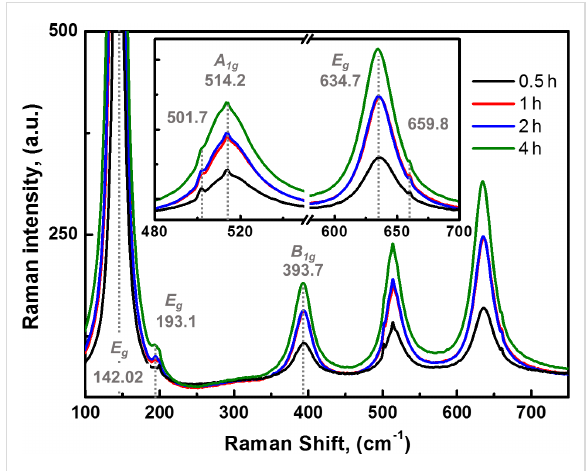
Figure 4: Raman spectra for TNT grown at different t a . Laser intensity: 2.5 mW/cm 2